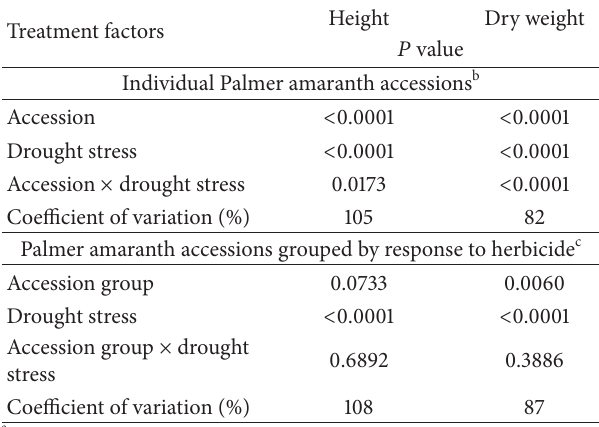
Table 2: 𝑃 > 𝐹 for percent reduction in height and dry weight of 15 Palmer amaranth accessions 30 days after emergence a